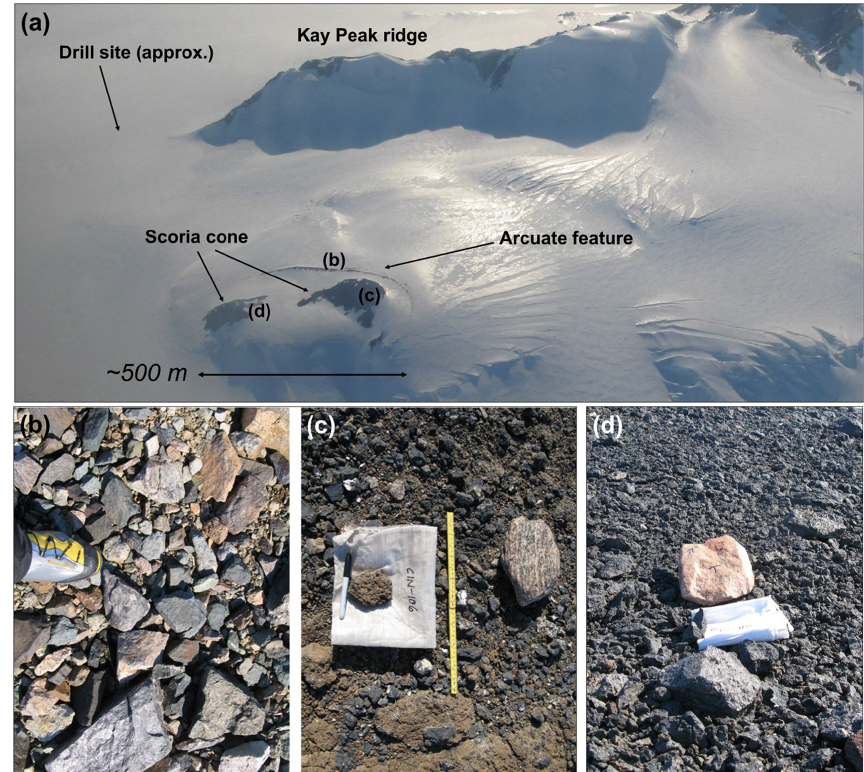
Figure 3. Geomorphic difference among clasts deposited at the scoria cone. (a) Image showing location of the scoria cone site in relation to Kay Peak ridge. Horizontal black line indicates approximate scale. (b) Clasts forming the arcuate ridge landform. (c, d) Erratic cobbles (samples CIN-106 and CIN-110) perched on the bedrock of the scoria cone. Approximate locations of clasts displayed in (b–d) shown in top panel. Scale indicated by boot (b) , 50cm ruler (c) and sample bag (d) . Images of all scoria cone erratics collected for exposure dating are provided in the Supplement (Fig. S3). Photo credit: Joanne S. Johnson and Stephen J.